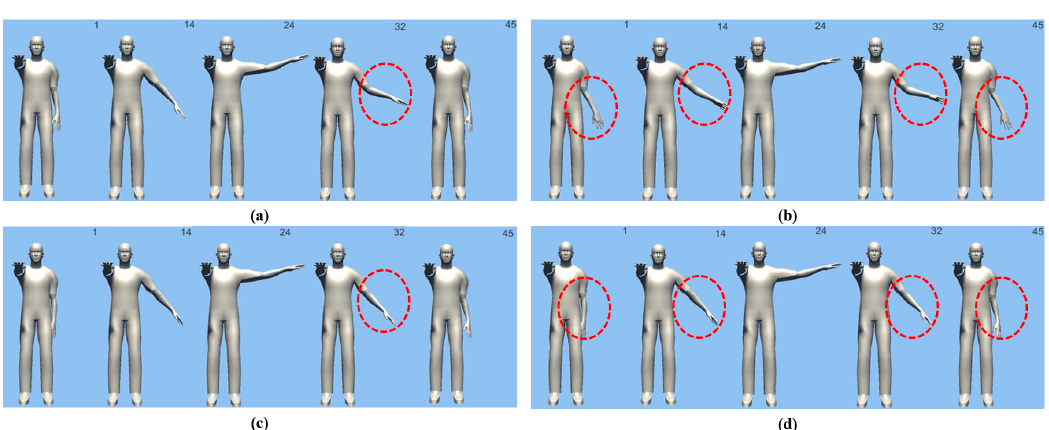
Figure 10. The following figure is a comparison of the experimental results of the previous studies on the Abduction motion and the proposed studies. Motion Estimation result Screen of Proposed Method ( a ) Screenshot of raw orientation x, y, and z ( b ) Shows the results of the previous research ( c ) Shows the motion estimation result after applying the weight of the genetic algorithm ( d ) Shows the Bayesian probability estimation result that reflects the weight.